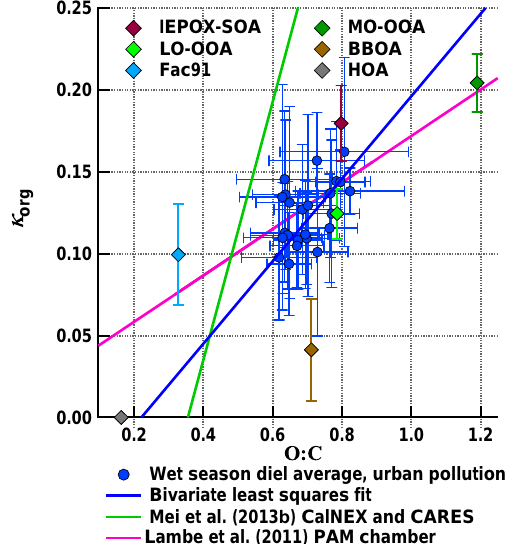
Figure 12. The variation of PMF factor hygroscopicity, 1h diel av- erage of organic hygroscopicity, and O:C ratio at 142 and 171nm for local biomass burning air masses. Also shown are the relation- ships between κ org and O:C reported by earlier field and laboratory